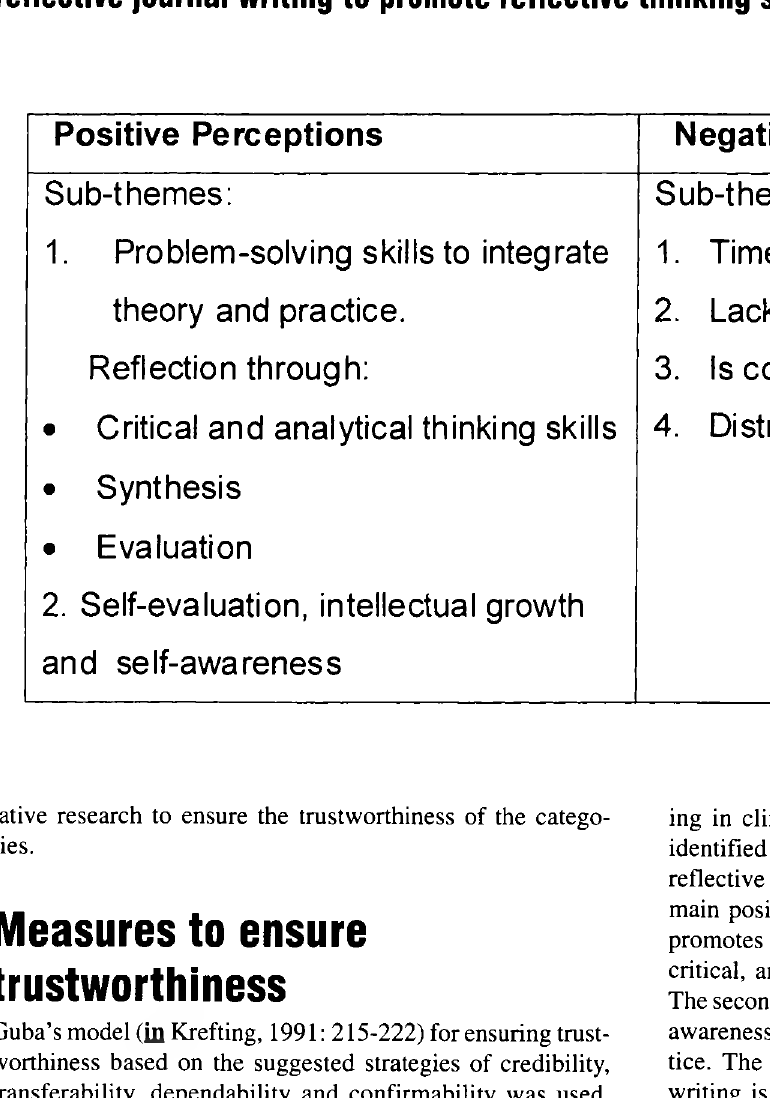
Table 1 : An overview of major themes and sub-themes of perceptions with regard to the use of reflective journal writing to promote reflective thinking skills in clinical nursing